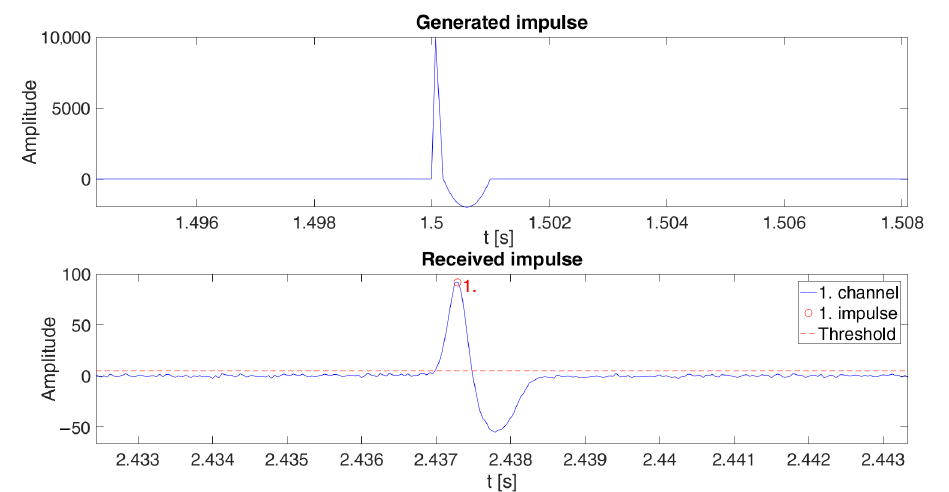
Figure 4. The generated and received impulse in the reference